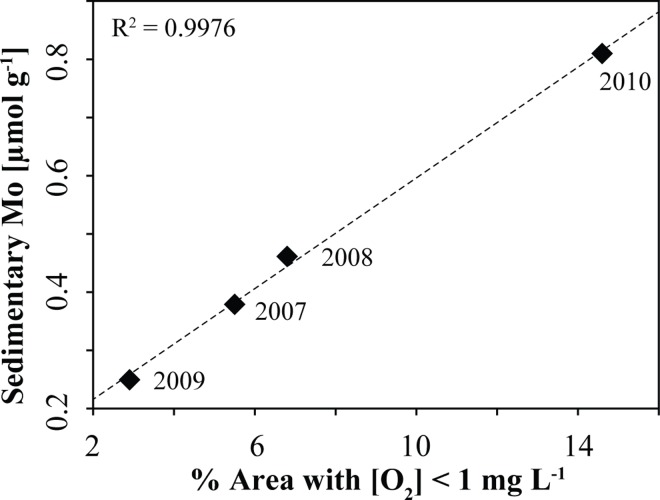
A comparison between the measured sedimentary Mo peak concentrations and the reported area of hypoxia for the years 2007 to 2010 [39] reveals a linear correlation (y = 0.0475x + 0.121).